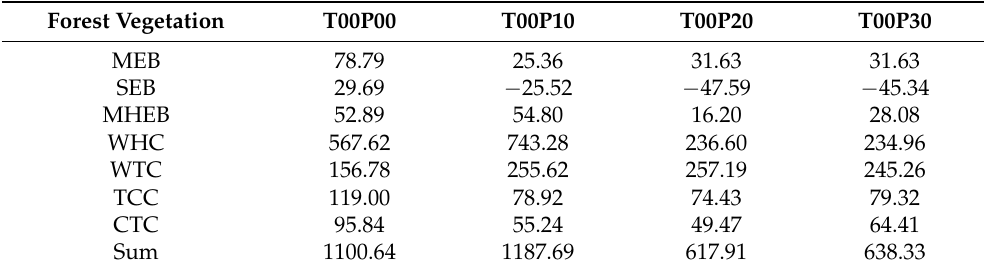
Table 7. CSP of forest vegetation in Yunnan Province under different precipitation decrease scenarios. Unit: